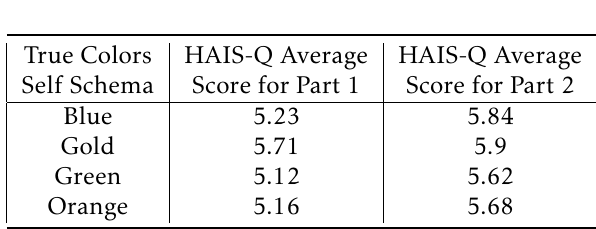
Table 1. The average HAIS-Q score for each True Colors self